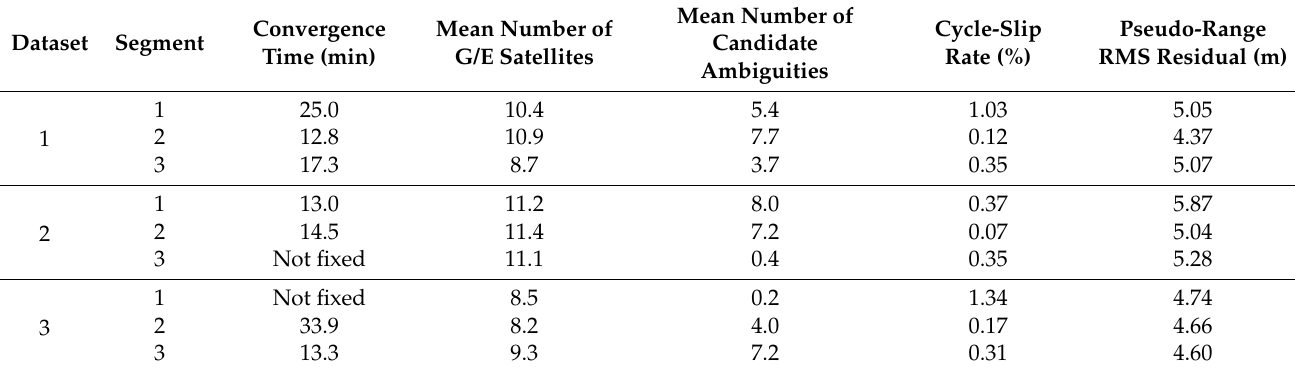
Table 8. Statistical results of solutions per segment.